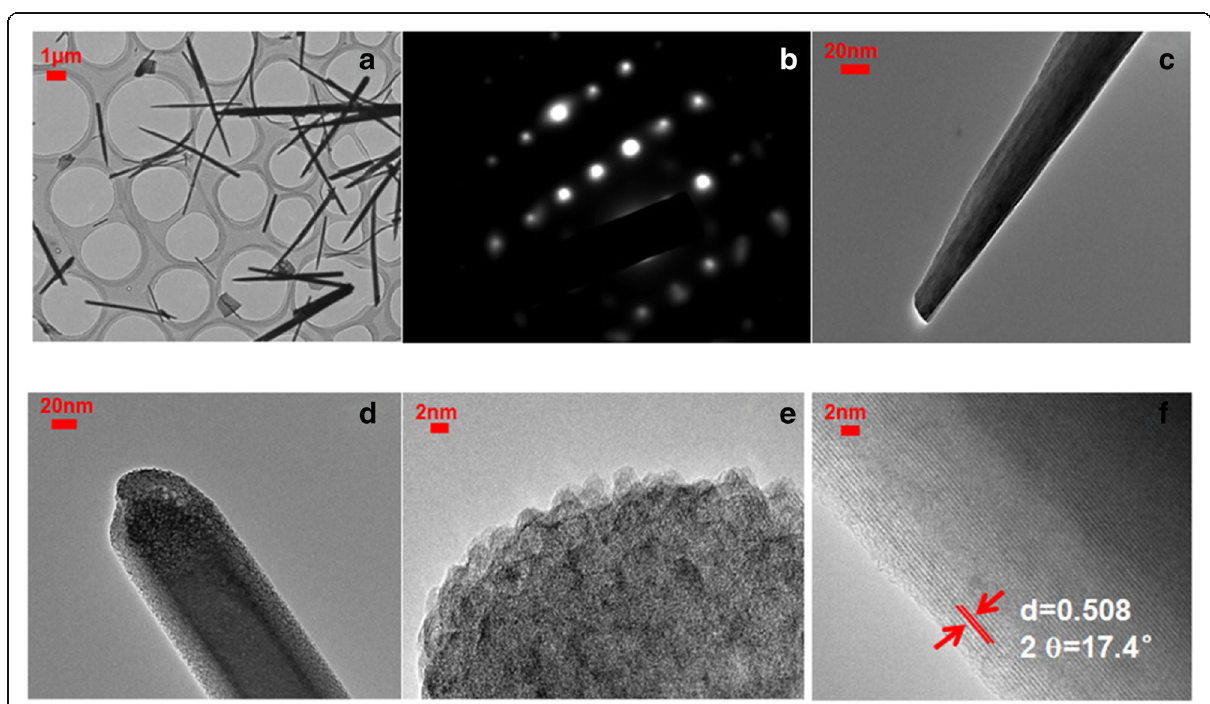
Fig. 3 a TEM images of Co-ClNWs. b SEAD pattern of Co-ClNWs. c – e TEM images of Co-ClNWs at high magnification (showing surface mesoporous structure in ( d ), the particles are compactly arranged to form Co-ClNWs in ( e )). f HRTEM images of the